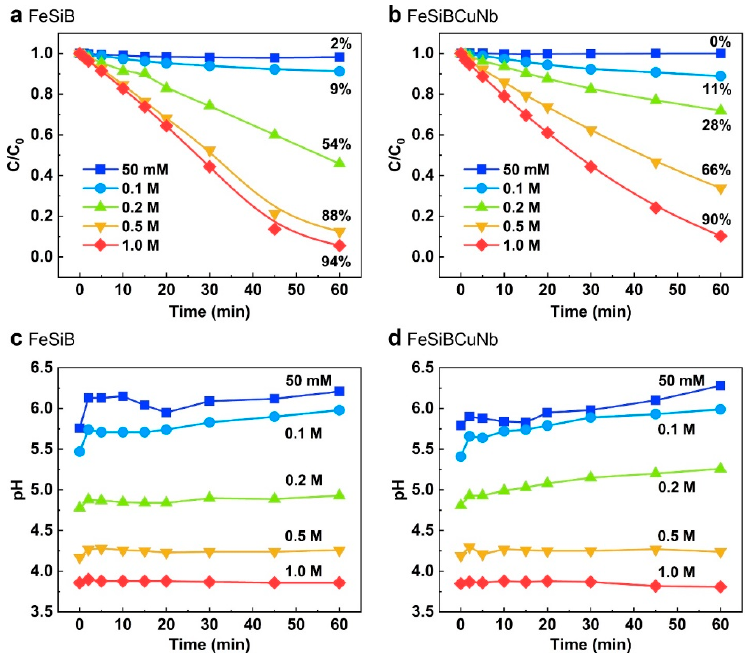
Figure 9. Effect of H 2 O 2 concentrations by ( a ) Fe 78 Si 9 B 13 (FeSiB) and ( b ) Fe 73.5 Si 13.5 B 9 Cu 1 Nb 3 (FeSiBCuNb) metallic glass ribbons (0.5 g/L) under neutral conditions (pH 6.2 ± 0.1) and UV-Vis irradiation (7.7 μ W/cm 2 ). ( c , d ) pH variation along reaction time corresponding to ( a , b ), respectively. Decolorization rates were measured from the λ max of the corresponding UV-Vis spectra with reaction time.